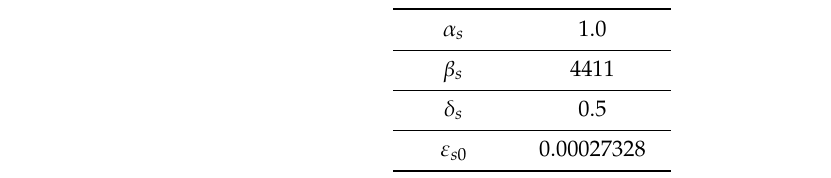
Table 9. Strand7 shrinkage input